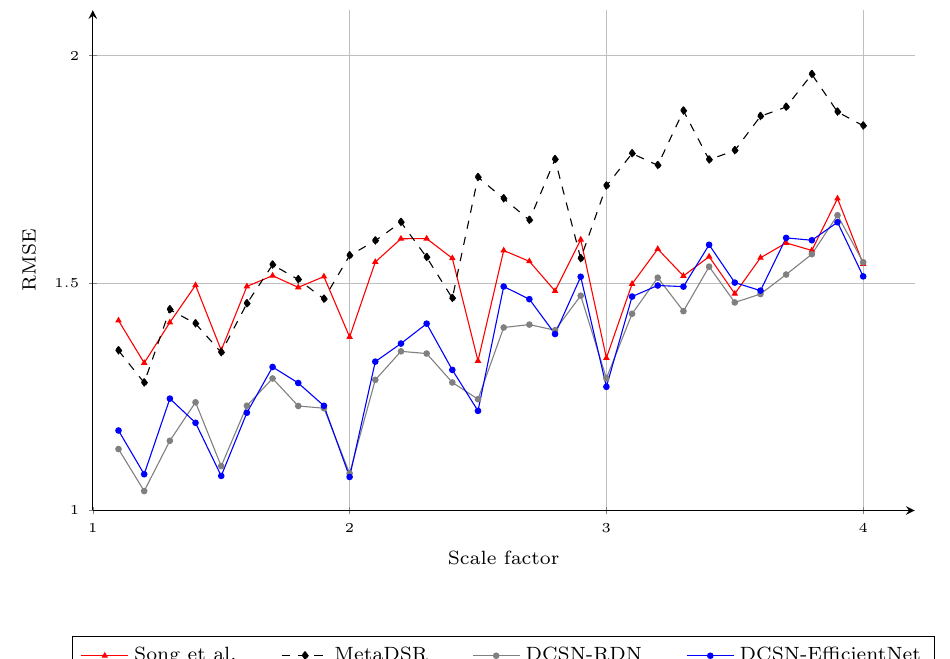
Figure 7. The RMSE of different methods for different upsampling factors [ 1.1,1.2,...,3.9,4.0 ] on noisy input depth maps. We report the results of the model in [40] trained with arbitrary scale factors, rather than the model trained with specific scaling factors, for a fair comparison. Note that the results of the method of Song et al. for noninteger scale factors were obtained by applying bicubic interpolation to the upscaled results of the nearest integer scale factor.